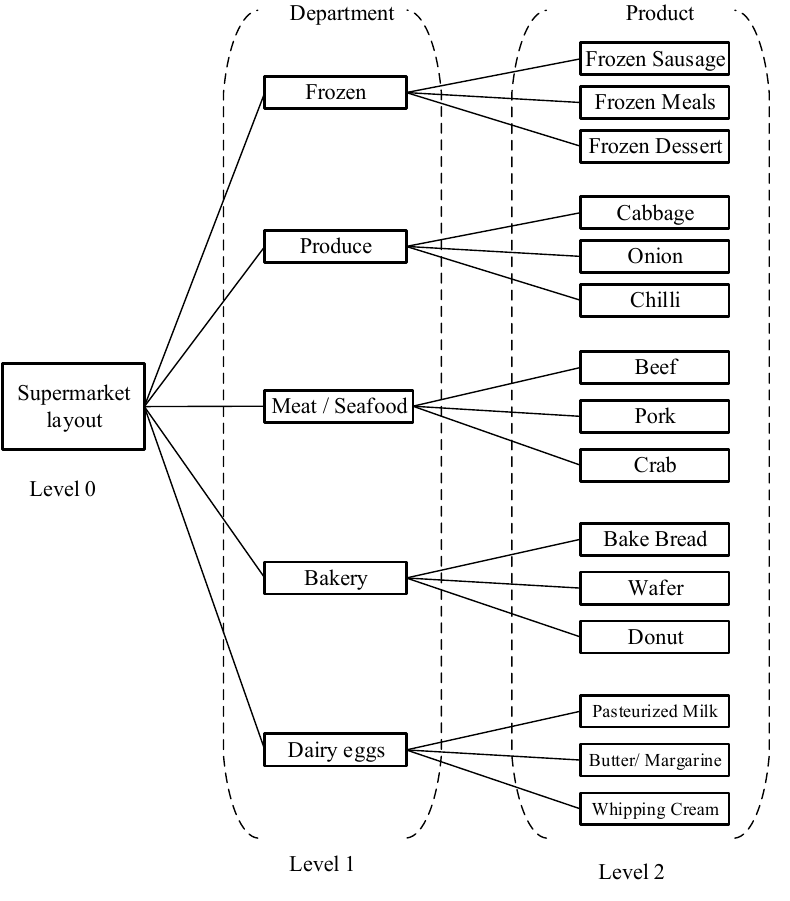
Figure 1. Hierarchical structure of supermarket products. Table 2. A supermarket’s order transaction database.